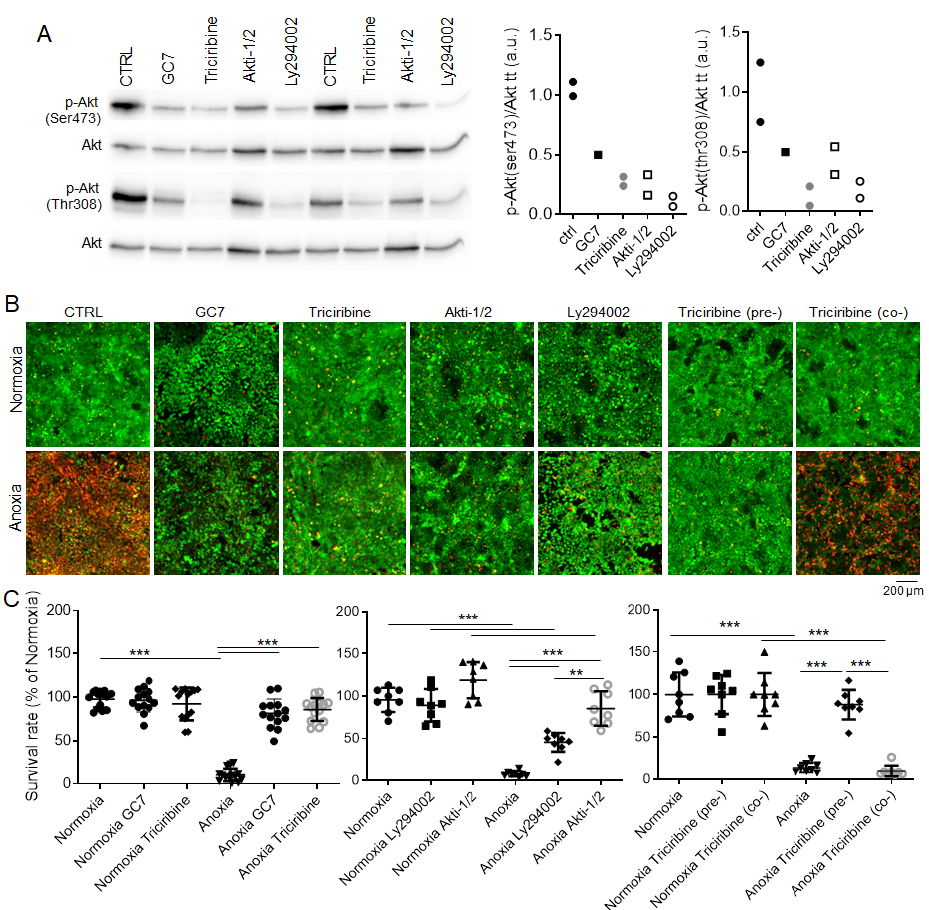
Figure 2. Inhibition of Akt promotes PCT cell survival under anoxia. ( A ) PCT cells were treated or not for 24 h with GC7 (30 µM) and for 30 min with triciribine (1 µM), Akti-1/2 (10 µM) and Ly294002 (50 µM). At the end of treatment, phosphorylation of Akt on both Ser(473) and Thr(308) sites were assessed by Western blot as well as total Akt. Scatter plot representation of individual p-Akt/Akt band intensities values from adjacent Western blots. ( B , C ) PCT cells were treated or not with GC7 (30 µM), triciribine (1 µM), Akti-1/2 (10 µM) and Ly294002 (50 µM) for 24 h. Then, cells were retreated and either maintained under normoxia or submitted to anoxia for another 24 h. triciribine (pre-): cells were treated the first 24 h before anoxia; triciribine (co-): cells were treated just at the moment of anoxia. Cell viability was then evaluated using a live/dead fluorescence assay. ( B ) Representative images of each condition with live (green, calcein-FITC) and dead (red, ethidium bromide homodimer) cells and ( C ) corresponding survival rate (live/dead cells). Scatter plot representation of individual values along with mean ± SD. n = 14 or 8. ** p < 0.01, *** p < 0.001.